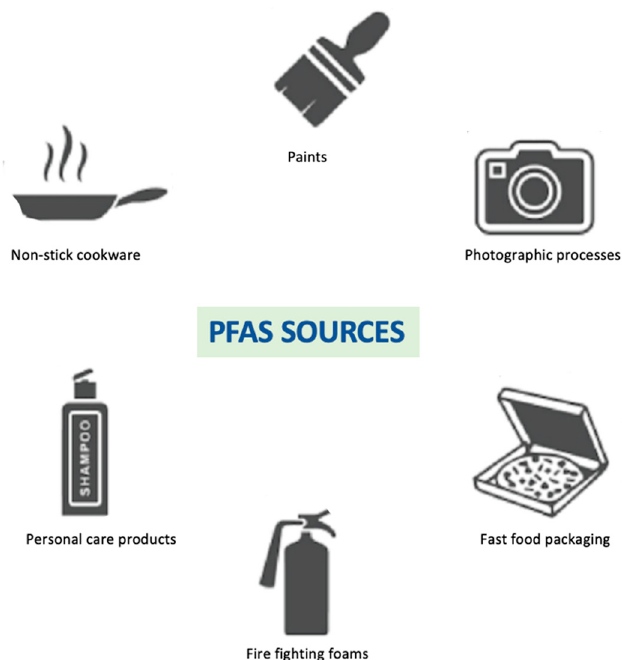
Figure 3. Main sources of PFAS.